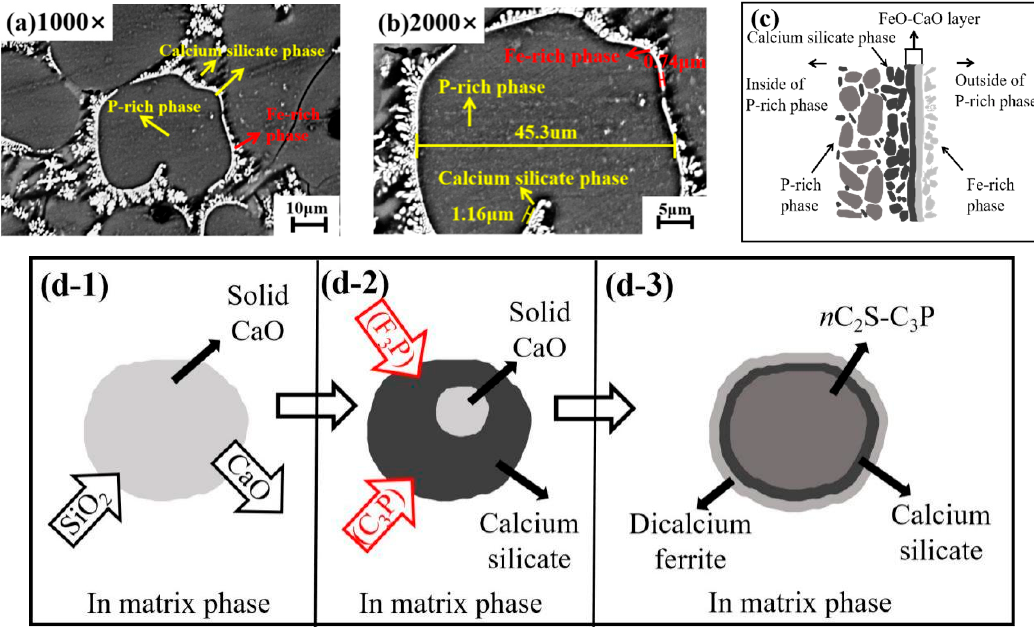
Figure 7. Images of the P-rich phase in dephosphorization slag at 1405 °C of ( a ) 1000 times; ( b ) 2000 times; ( c ) Schematic diagram of P-rich phase boundary; ( d ) Schematic diagram of formation process of the P-rich phase.